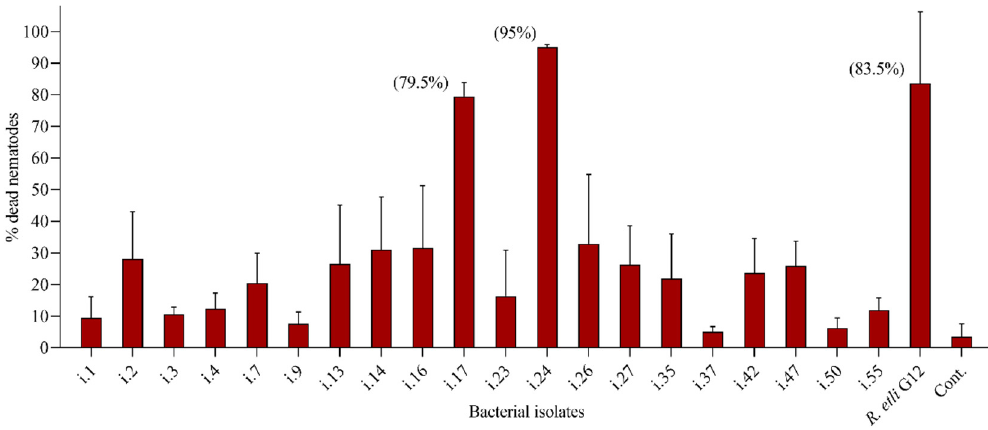
Figure 8. Effect of the nematode-isolated bacterial isolates on mortality of Pratylenchus penetrans after attachment to the cuticle. Cont.: negative control in sterile tap water. Error bars represent standard deviations, n = 3.